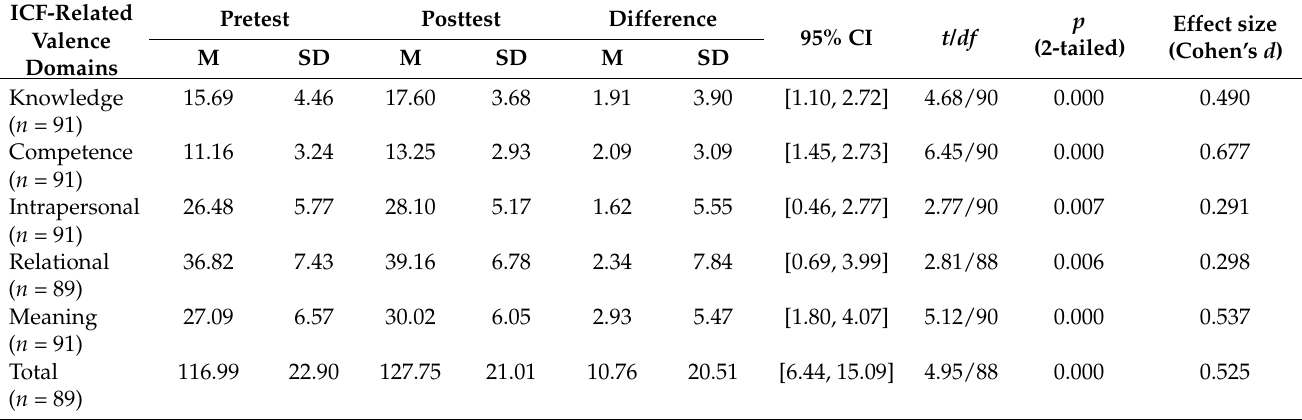
Table 2. Paired t -test results of various ICF-related valence domains.